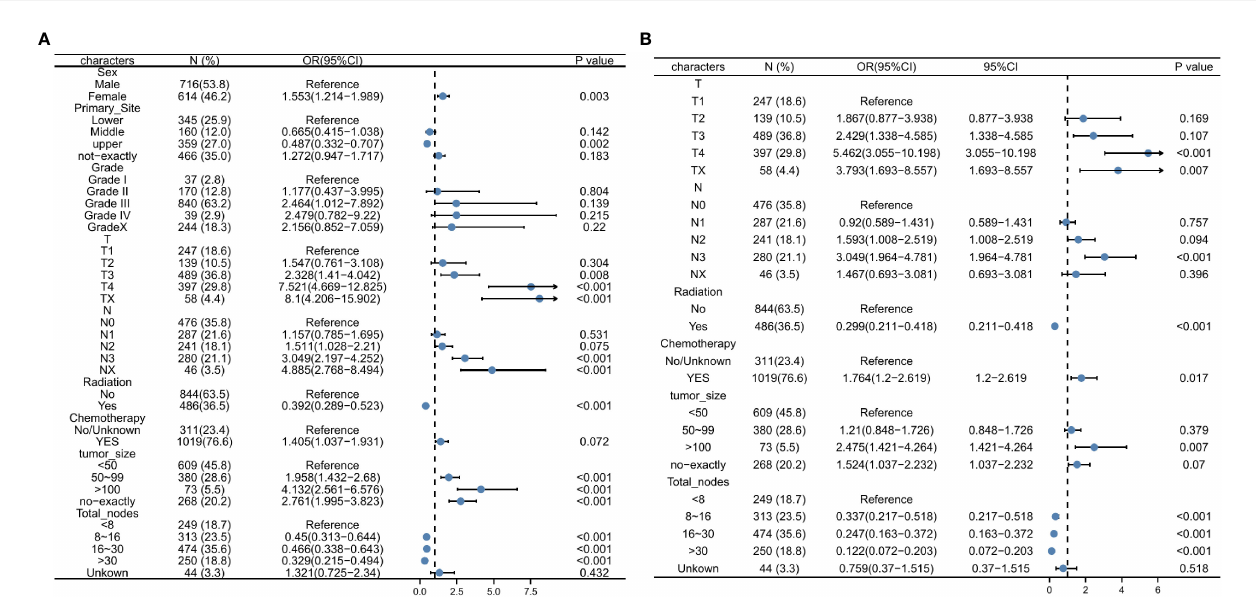
FIGURE 3 Univariate logistic regression analysis for predicting the DM (A) , Multivariate logistic regression analysis for predicting the DM (B) . DM, distant